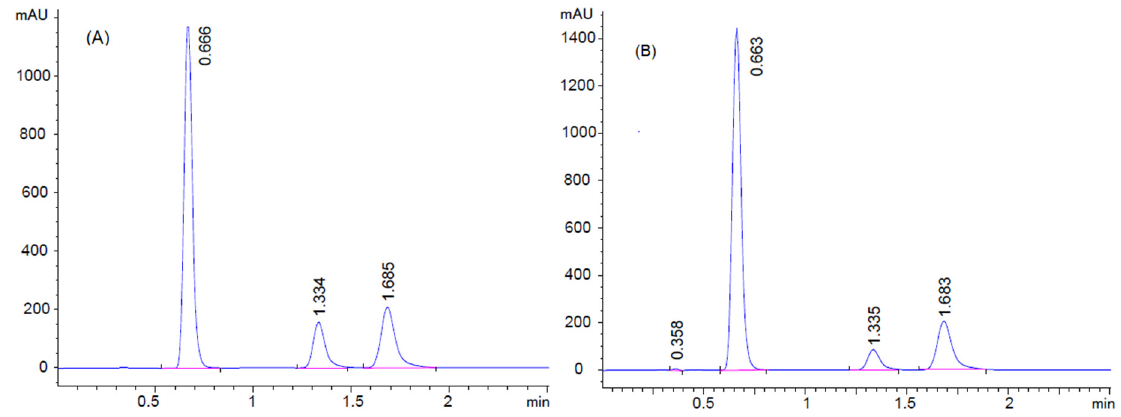
Figure 8. Representative chromatograms of standard solution ( A ) and formulation solution ( B ). The retention time of RFH:0.66 min, RGE:1.33 min, and IS:1.68 min.